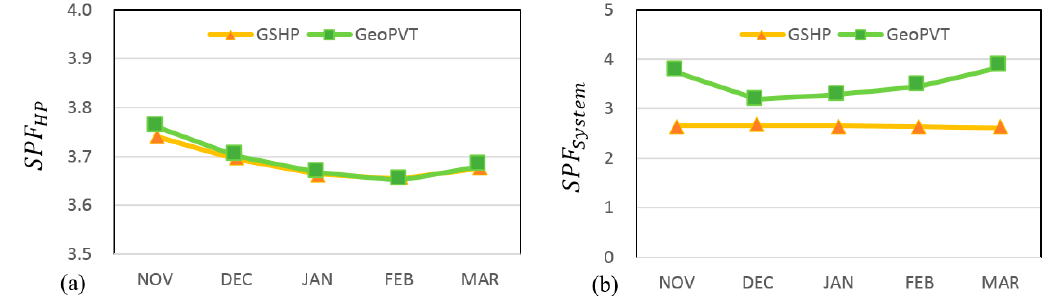
Figure 21. The result of SPF during daytime operation in heating season. ( a ) Heat pump; ( b ) system.